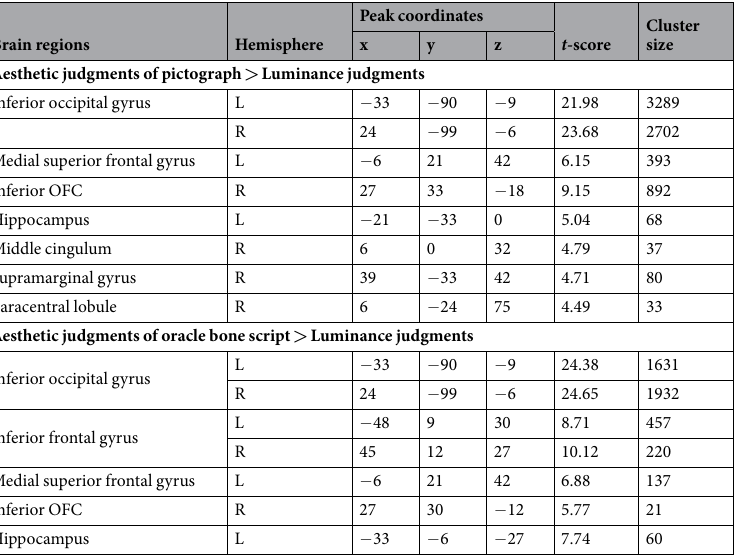
Table 6. Brain regions for aesthetic judgments of pictographs and oracle bone scripts regardless of the aesthetic valence. Note: Coordinates refer to the stereotactic space of the Montreal Neurological Institute. The statistical significance refers to p < 0.001 at voxel level (uncorrected), p < 0.05 at cluster level (FWE corrected).